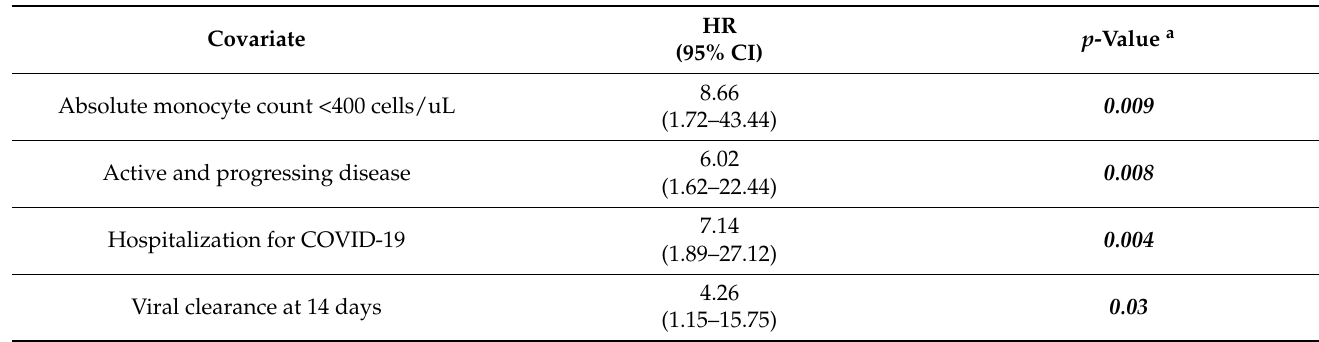
Table 6. Multivariable analysis of median overall survival based on main pre-infection clinical and lab- oratory parameters found significant in univariate analysis in hematological patients with